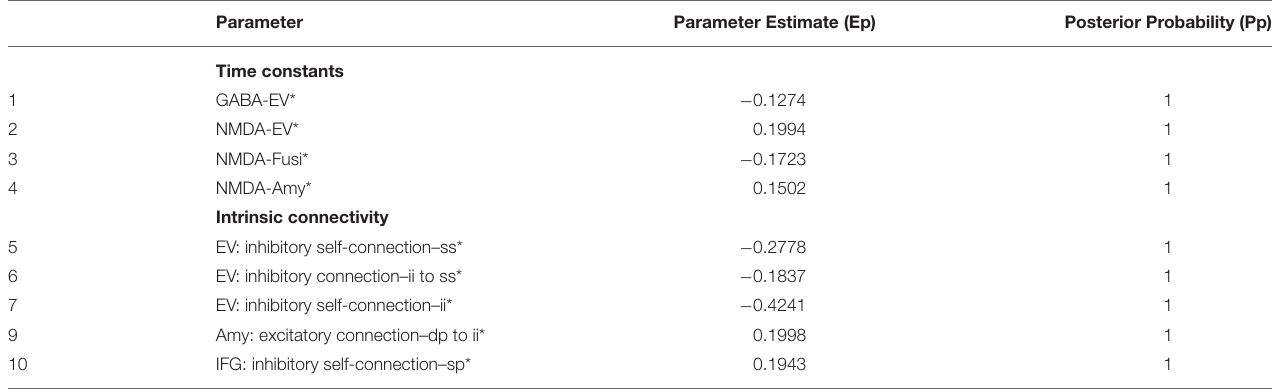
TABLE 3 | Group by drug interactions over parameters. Parameter Parameter Estimate (Ep)